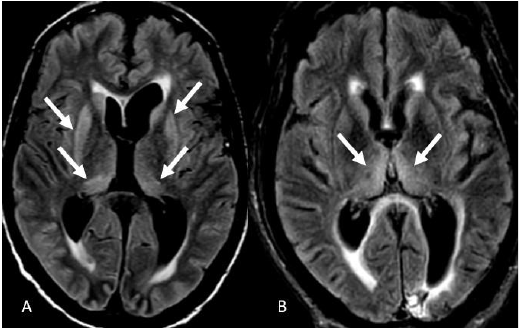
Figure 6. Basal ganglia and thalami involvement. ( A ) Axial FLAIR images show bilateral basal ganglia and thalami FLAIR hyperintensities. ( B ) Bilateral thalami FLAIR hyperintensities. Image has been windowed manually to improve the visibility of signal abnormality.